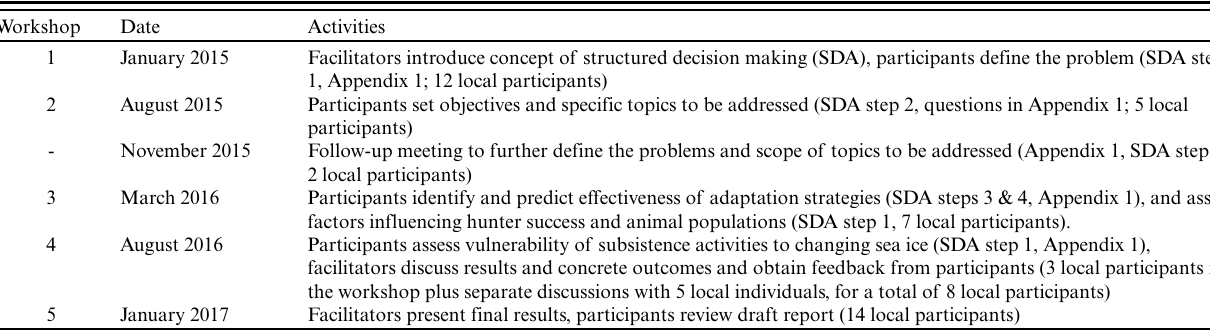
Table 1 . Workshop timeline.